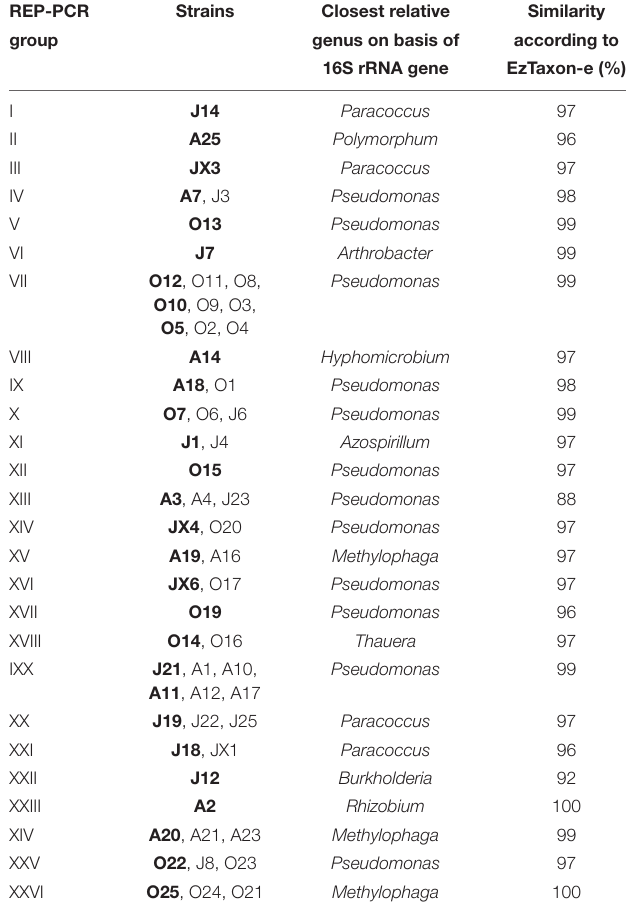
TABLE 5 | REP-PCR groups and taxonomic identification of representative strains isolated from sediments of La Caldera lake (Sierra Nevada, Spain) taken on June 9, August 1, and October 13, 2015.